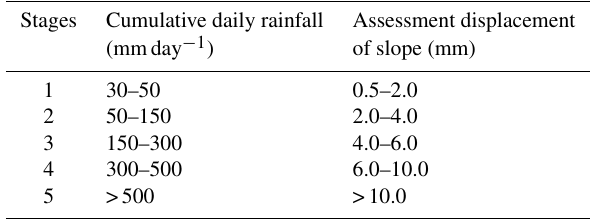
Table 1. Preliminary relationship between displacement of the in- clinometer and daily rainfall for the